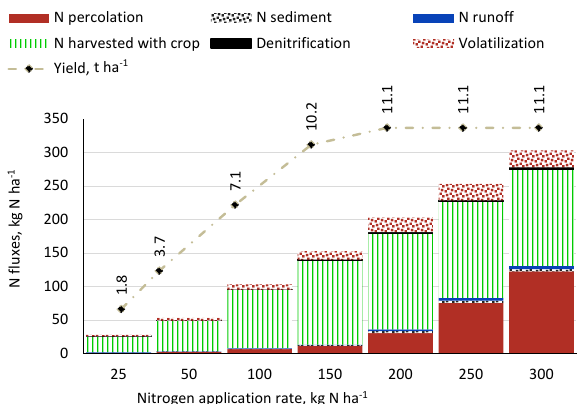
Figure 2. Nitrogen outfluxes and yield for an irrigated maize field for a range of N application rates under the reference management package (inorganic N, conventional tillage, full irrigation).